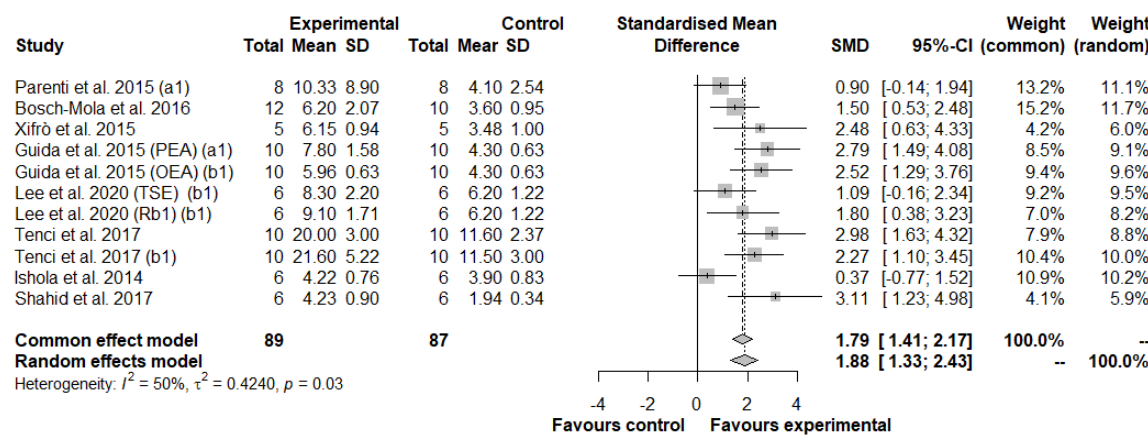
Figure 4. Forest plot showing the nutraceutical effects in thermal hyperalgesia by measuring the withdrawal latency in the injured paw. SD, standard deviation; SMD, standardized mean differences; CI, confidence interval.